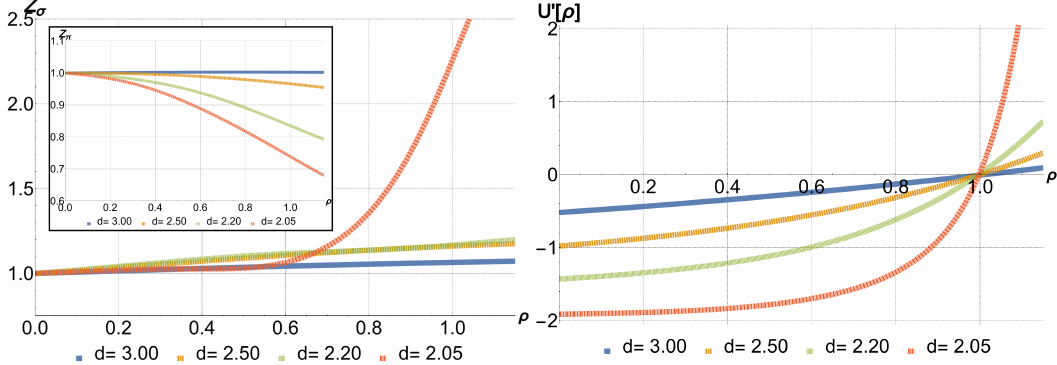
Figure 11: Critical fixed points for N = 2.5 and a series of values of d . The left panel shows the fluctuations suppressors: longitudinal z σ ( ˜ ρ ) (main plot) and transverse z π ( ˜ ρ ) (inset). Particularly visible is the drastic (but smooth) increase of z σ ( ˜ ρ ) upon crossing the C-H line located slightly below d = 2.2. The right panel shows the derivative of the local potential u (cid:48) ( ˜ ρ ) . The axes were rescaled, so that the minimum of the local potential always lies at ˜ ρ =